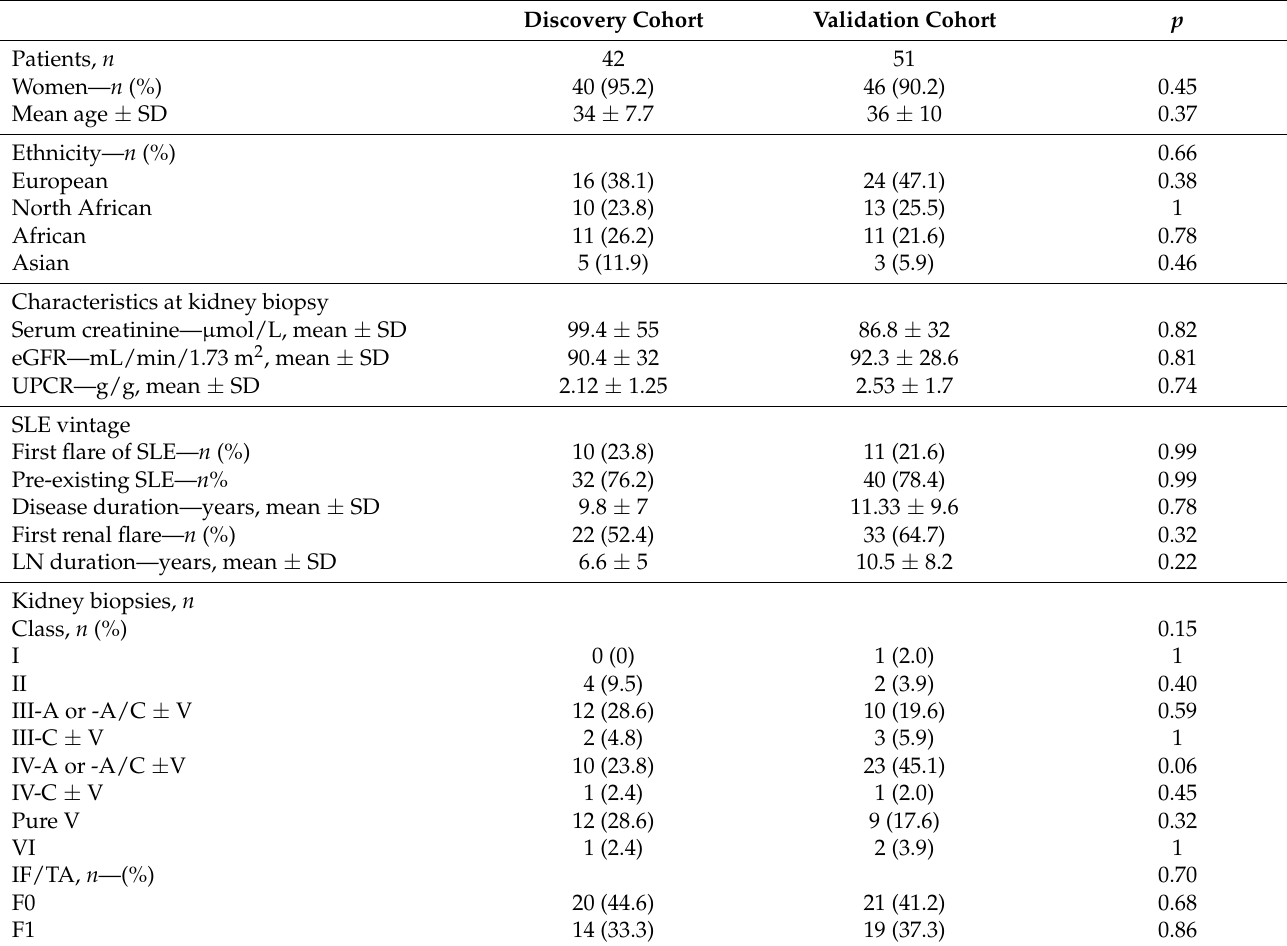
Table A1. Baseline characteristics of patients from the discovery and validation